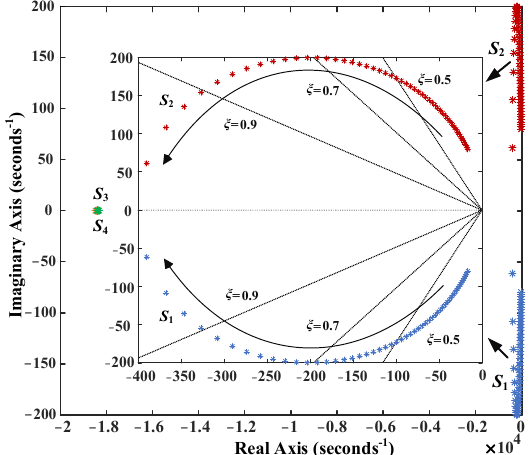
Figure 5. Characteristic root locus of the system with variation of M 4 .